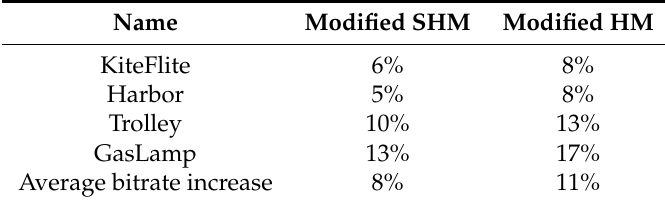
Table 5. Bitrate increase ratio compared to original encoding.